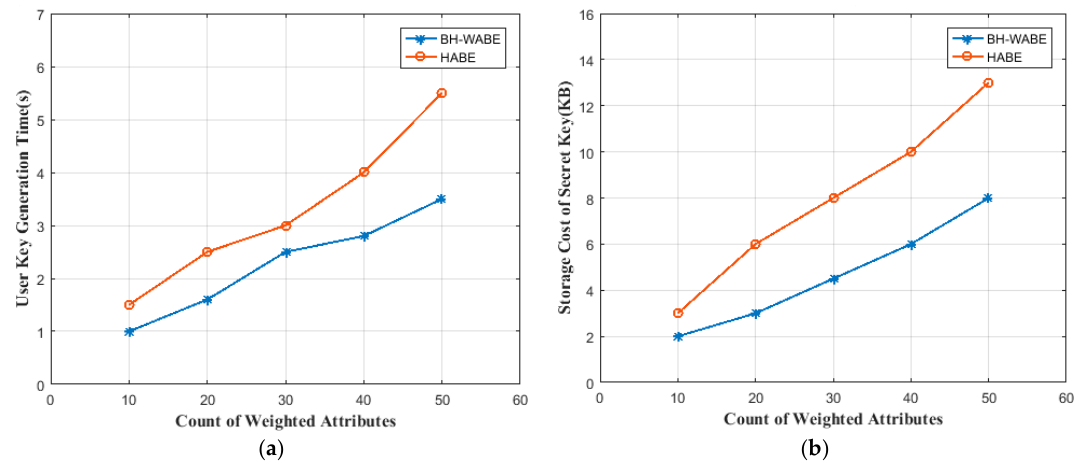
Figure 8. Cost of user secret key generation. ( a ) Time cost analysis; ( b ) Storage cost analysis